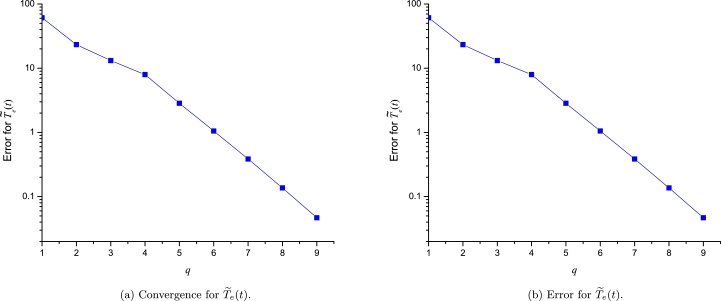
Convergence and error analysis for T˜e(t).